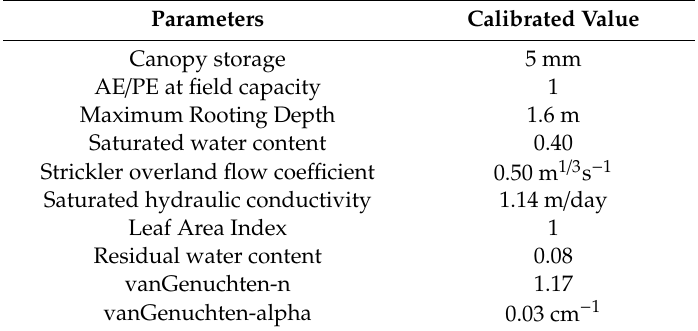
Table 2. Catchment properties calibrated using Système Hydrologique Européen Transport (SHETRAN). Table2. CatchmentpropertiescalibratedusingSyst è meHydrologiqueEurop é enTransport(SHETRAN).